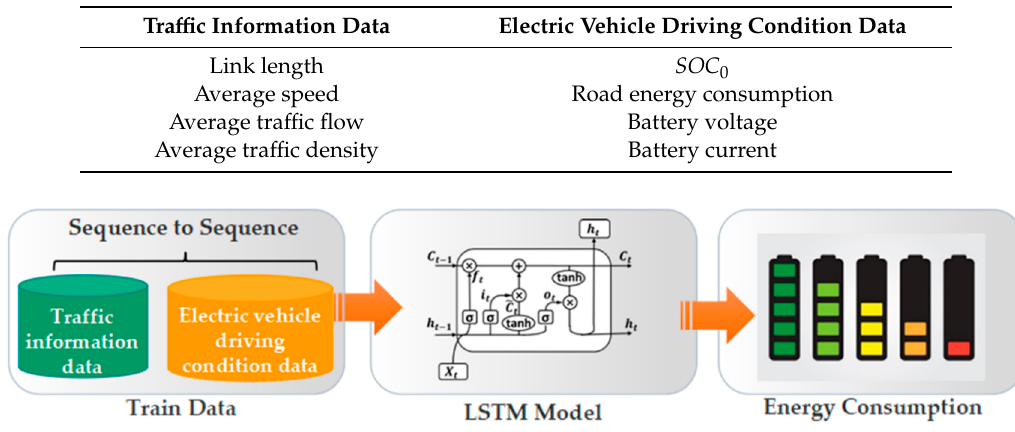
Figure 5. The framework of the EV energy consumption prediction model.